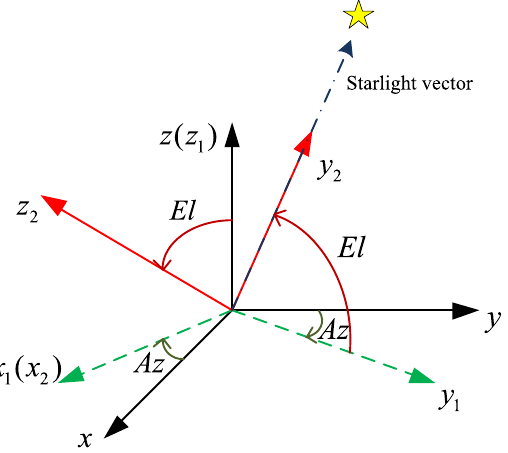
Figure 3. The definition of the azimuth and elevation